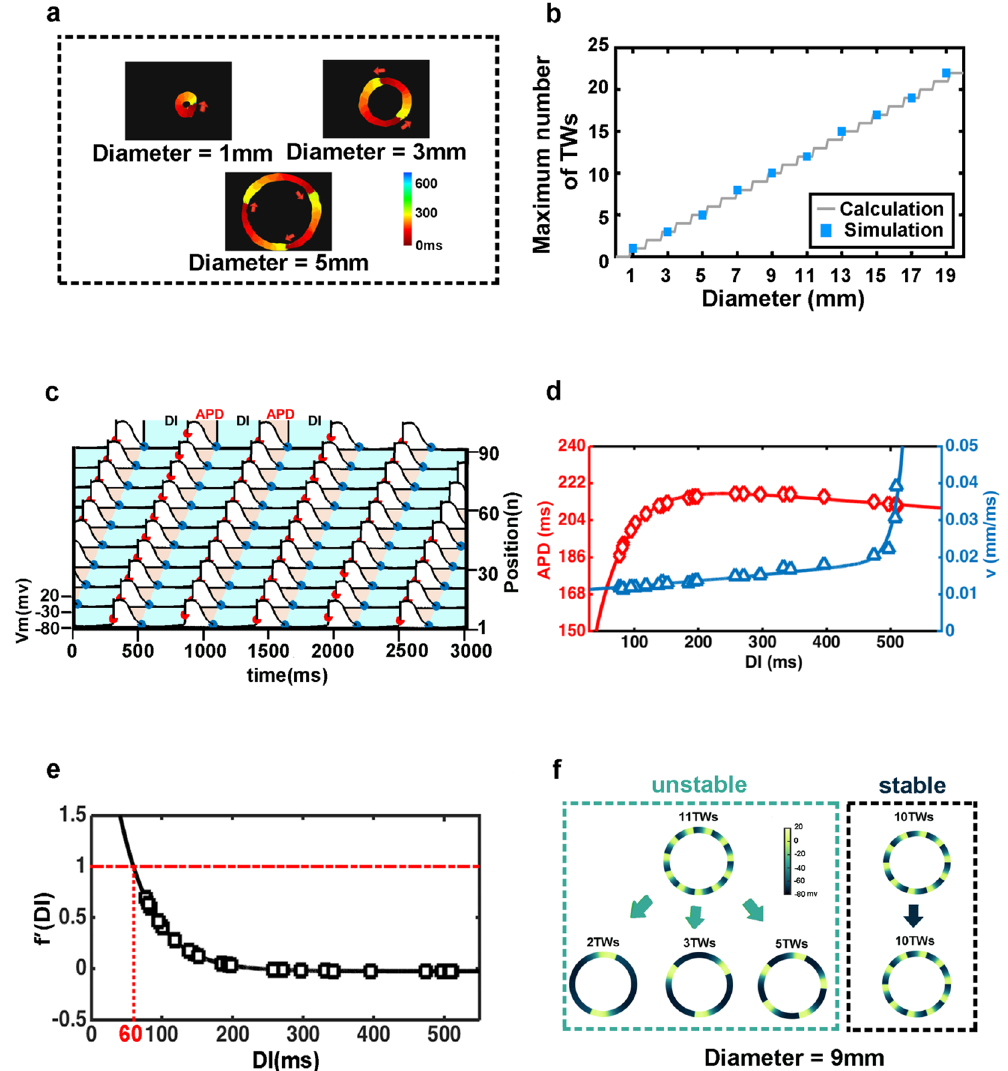
Figure 2. Maximum number of traveling waves, the definition of the action potential restitution function and the conduction velocity restitution function. ( a ) Activation map of GCaMP3-positive in SOTRs with 1TW in 1mm-ring, 2TWs in 3mm-ring, and 3TWs in 5mm-ring on day 6 (experimental data). The red arrows indicate the propagation direction of the traveling waves. ( b ) Maximum number of traveling waves in simulation (blue squares) and calculation (grey line). ( c ) Definition of action potential duration (APD) and diastolic interval (DI). ( d ) Curves of the action potential restitution function (red diamonds: simulation result; red line: fitting result) and the conduction velocity restitution function (blue triangles: simulation result; blue line: fitting result). ( e ) The derivative of the action potential restitution function (black line: calculation result; black squares: the corresponding derivative of the simulation result) and the threshold of the stable condition (red line). ( f ) Examples of stable and unstable traveling waves in a 9-mm diameter ring